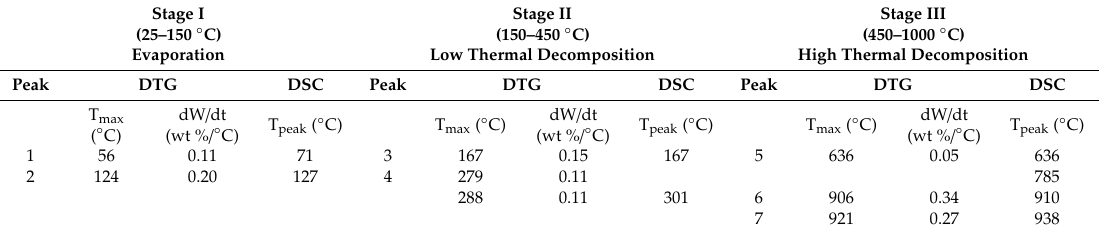
Table 1. Characteristic temperatures for the thermal decomposition of HCN-thermal derived polymer under argon atmosphere. DTG maxima with the corresponding rates of weight loss, dW / dt, and DSC peaks observed in the